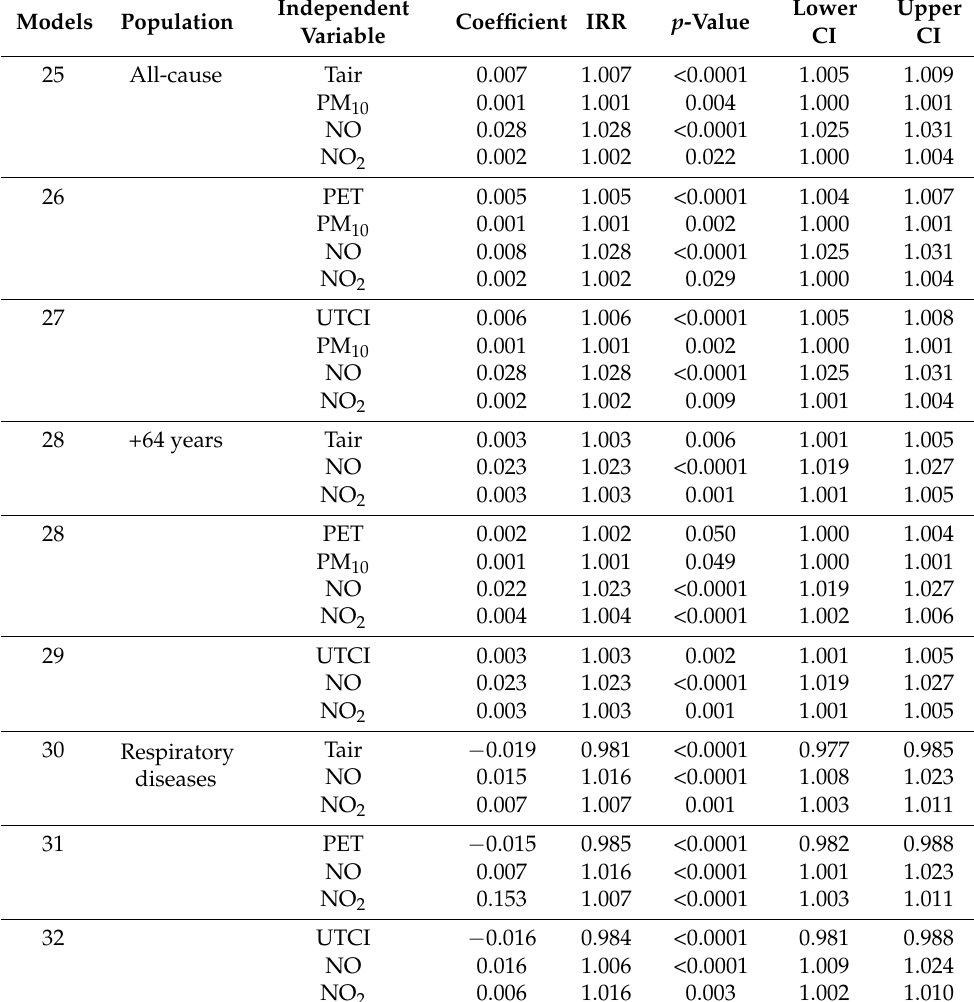
Table 5. Negative binomial regression models for the impact of the thermal environment on the number of hospital admissions (dependent variable) for April to August. All models are adjusted for admission year and